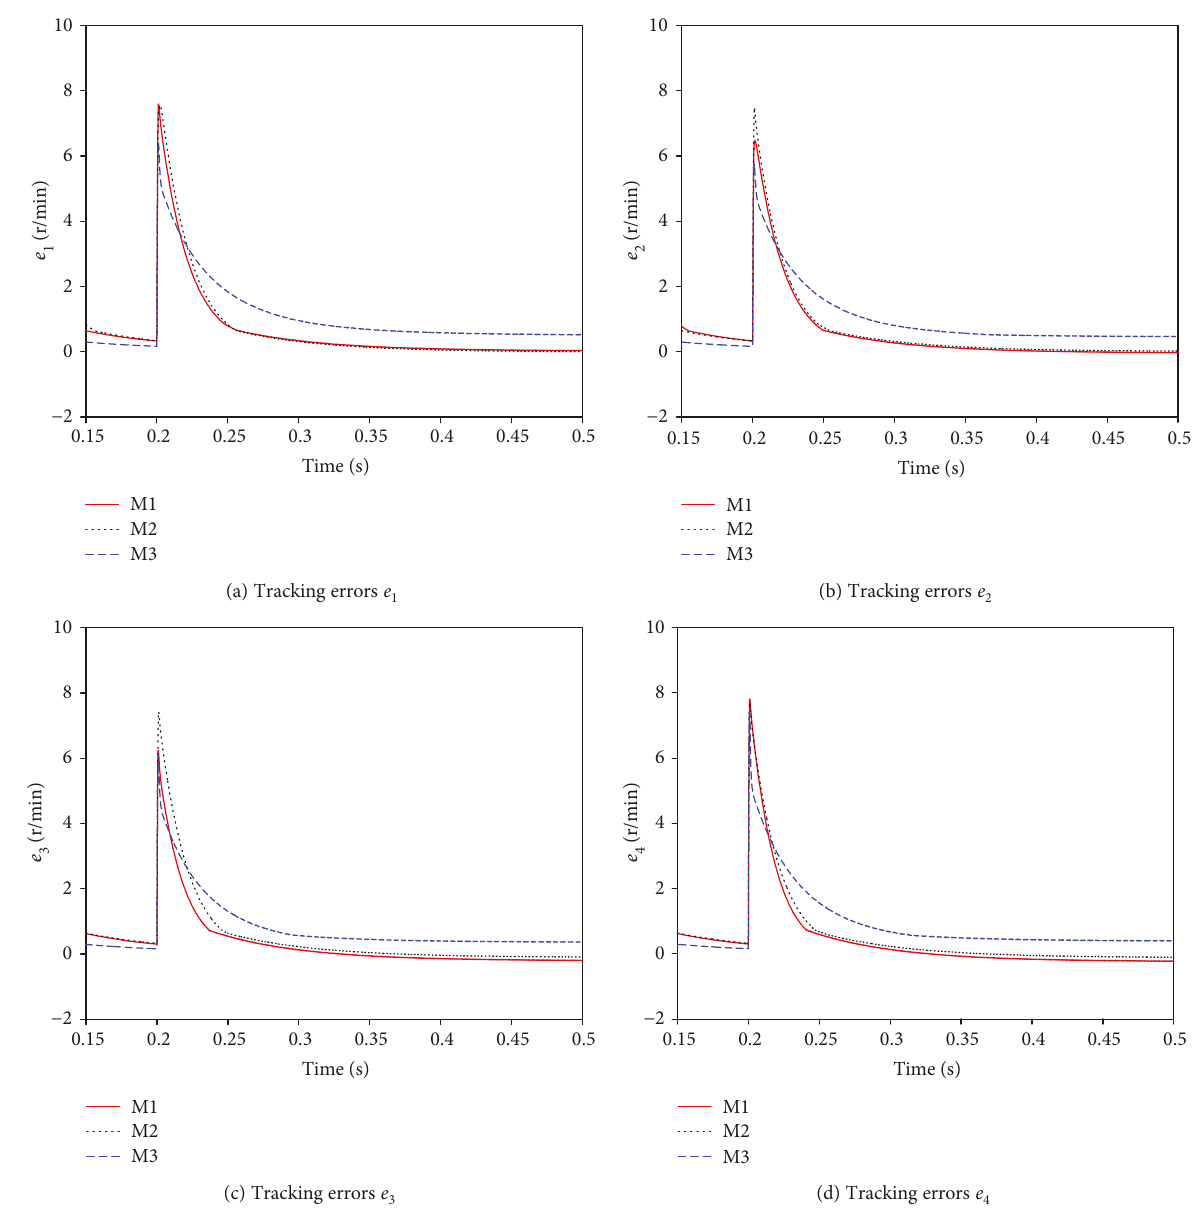
Figure 8: Tracking error